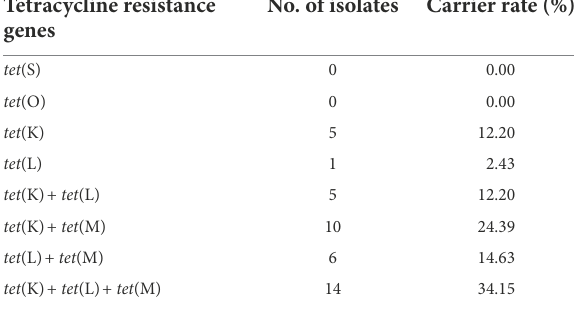
TABLE 2 Geographic distribution of 41 tetracyclines-resistant Staphylococcus aureus